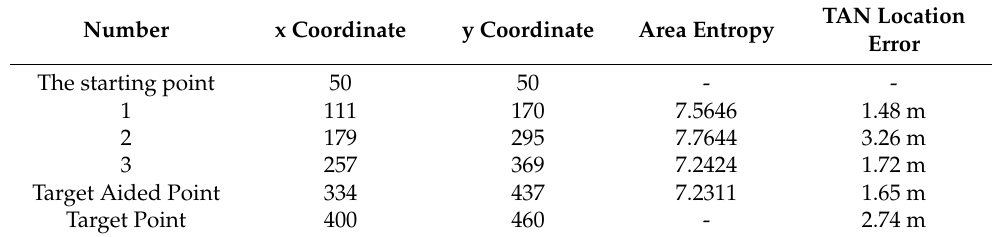
Table 10. Data of each point searched on the route of the second group of starting and ending